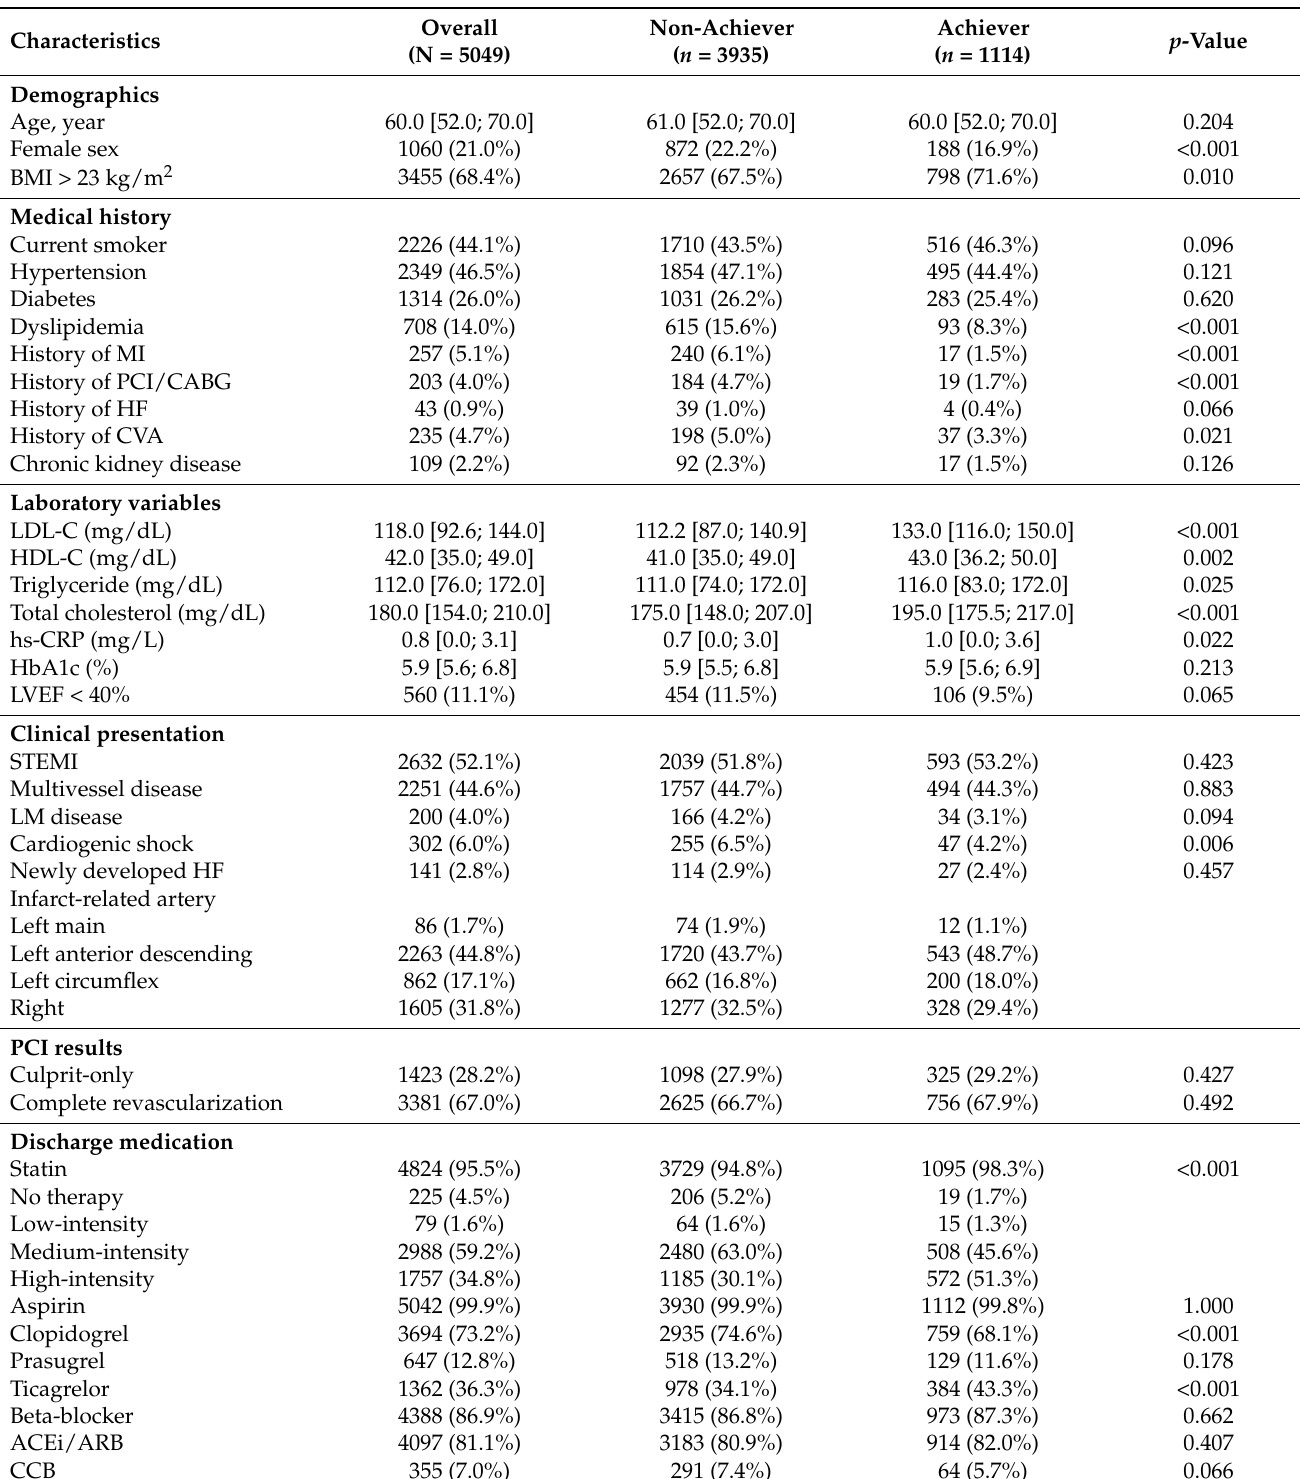
Table 1. Clinical characteristics at index myocardial infarction